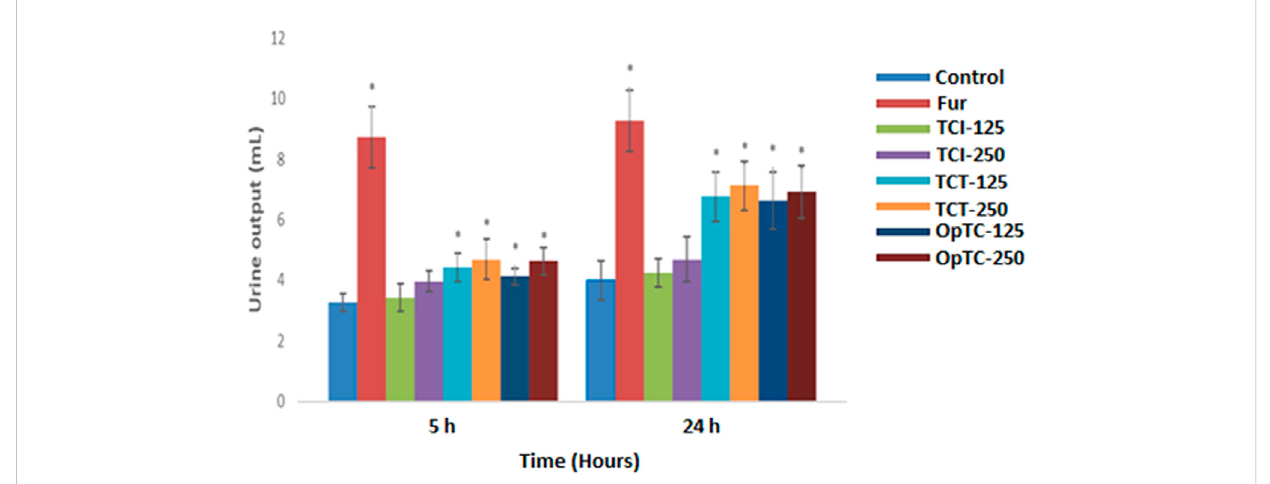
FIGURE 3 Effectofherbalpreparationsobtained from Thymus comosus onurineoutputrecordedat5and24 hinsalineloadedWistarrats(* p < 0.05vs.saline control).